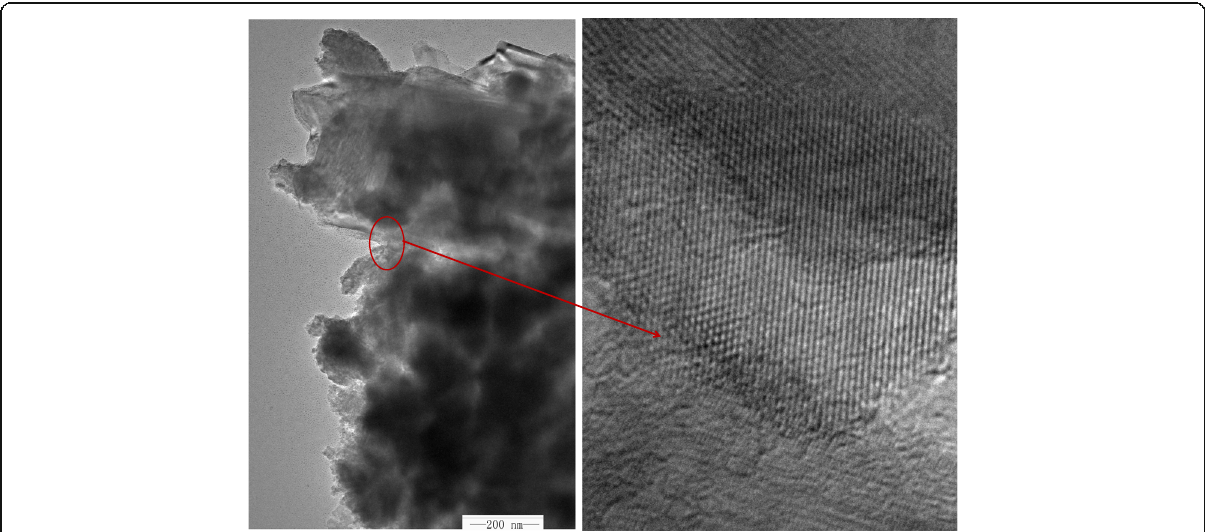
Fig. 2 TEM images of a hierarchical ZnO structure segment